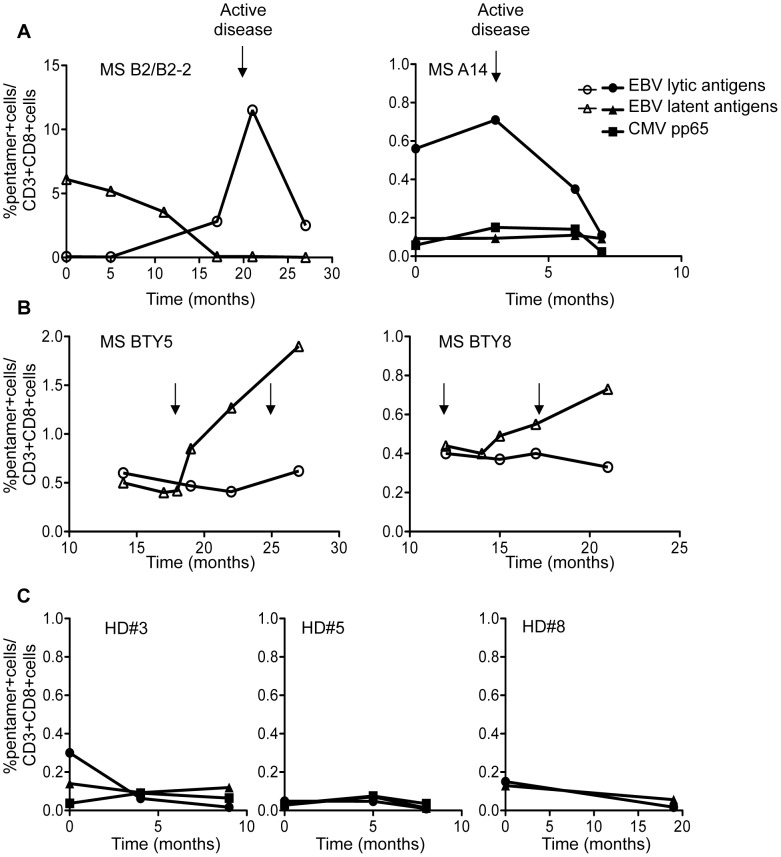
Longitudinal monitoring of EBV-specific CD8 T cell responses in relapsing remitting MS.The frequencies of CD8+ T cells specific for EBV lytic and latent antigens and CMV pp65 antigen were measured at different time points in 2 untreated MS patients (A), 2 natalizumab-treated MS patients (B) and 3 HD (C) using HLA-A*0201 and HLA-B*0801 pentamers. All patients were monitored clinically and with MRI at the times indicated by the arrows. The untreated MS patients had gadolinium-enhancing MRI lesions 20 days (MSB2/B2-2) and 1 day (MSA14) before the peak of the CD8+ T cell response to EBV lytic antigens while the 2 natalizumab-treated patients (MS BTY5 and MS BTY8) did not show any disease activity. Percentages of pentamer+ cells within the CD3+ CD8+ population are given on the y axis; the numbers on the x-axis indicate months since the start of the observation period (A, C) or of drug therapy (B).